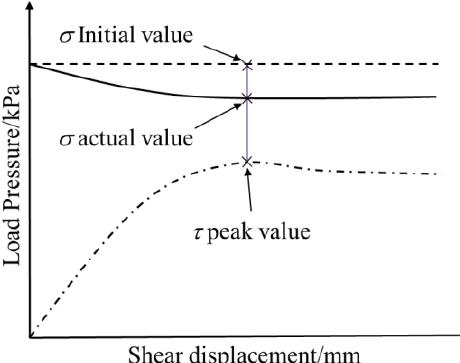
Figure 18. Interface shear strength normal stress value.